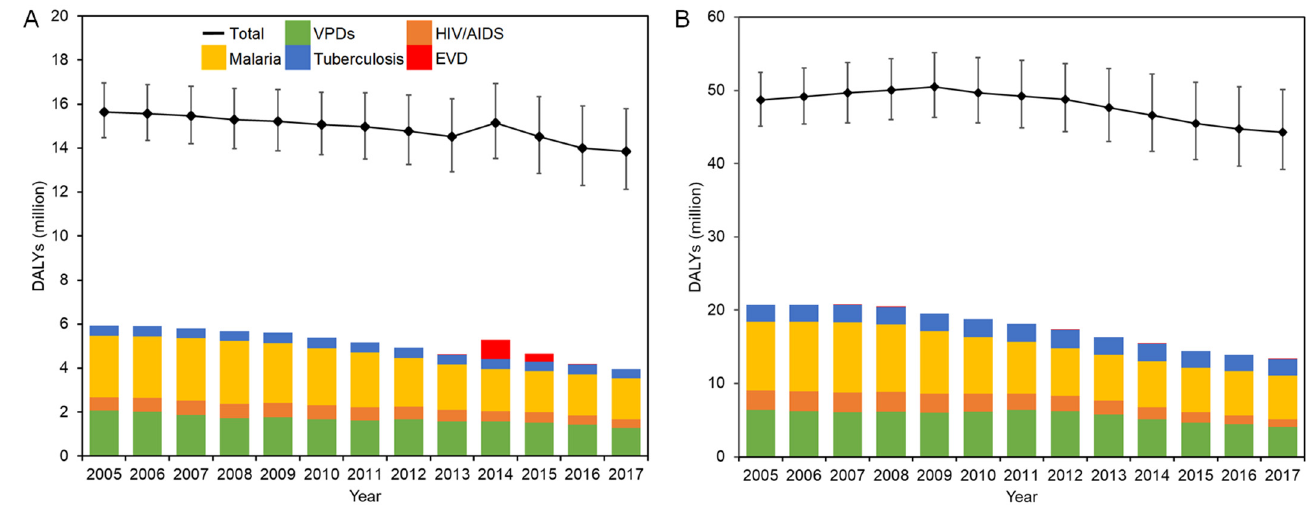
Figure 2. DALYs in EVD-affected countries in 2005–2017: ( A ) West Africa; ( B ) DRC. Solid squares represent the point estimates of all-cause DALYs, and whiskers extend to the upper and lower 95% confidence intervals.